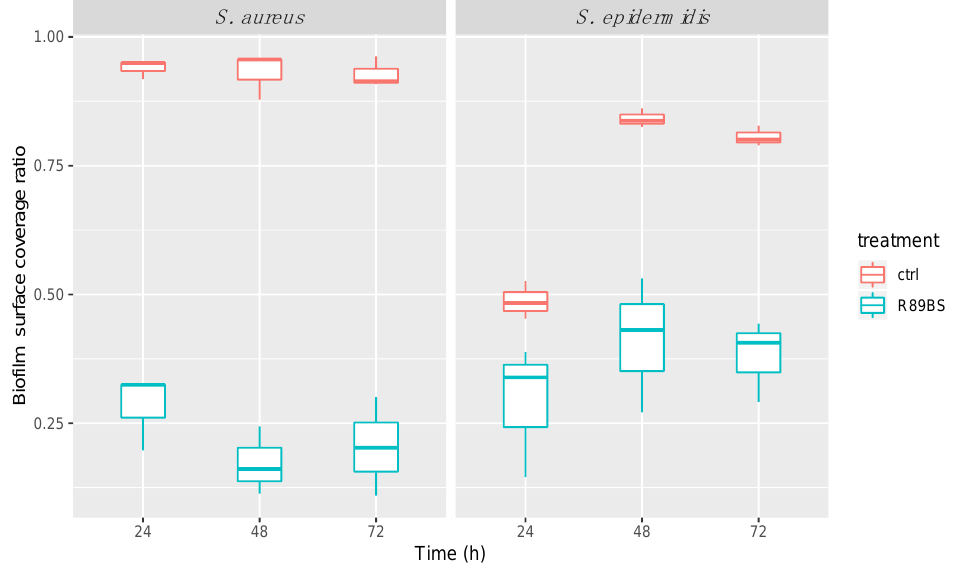
Figure 5. Quantitative evaluation of the biofilm surface coverage. Biofilm coverage surface was